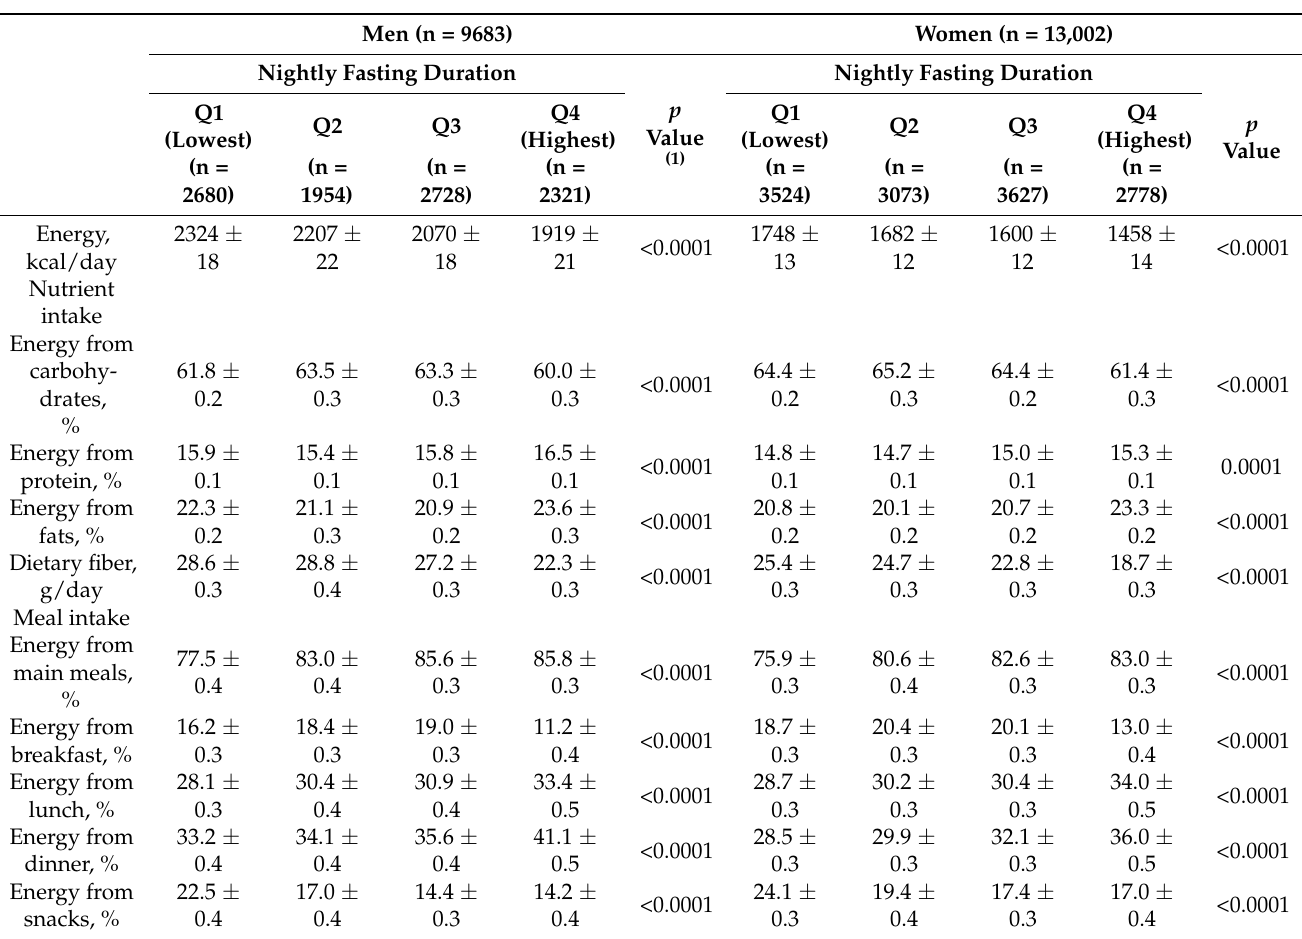
Table 2. Nutrient and meal intake of study participants based on the quartiles of nightly